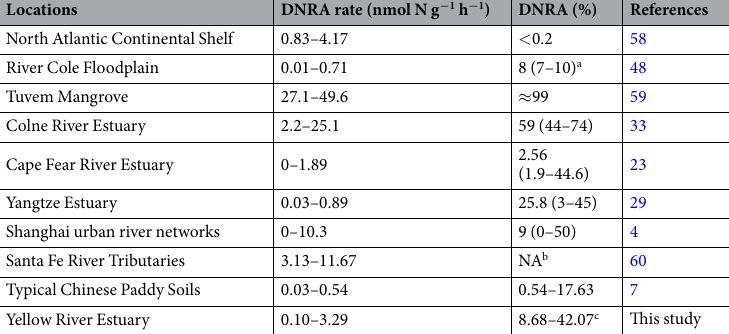
Table 2. DNRA rates and corresponding contributions to nitrate reduction in various ecosystems. a The percentage of DNRA in the total NO 3 − reduction (denitrification + DNRA); the rest studies in the column show the percentage of DNRA in the NO 3 − reduction (denitrification + DNRA + anammox). b NA represents no available data. c The percentage of DNRA in the total nitrate reduction were estimated where rates of denitrification and anammox in some sites of the Yangtze Estuary were used to serve as data in this